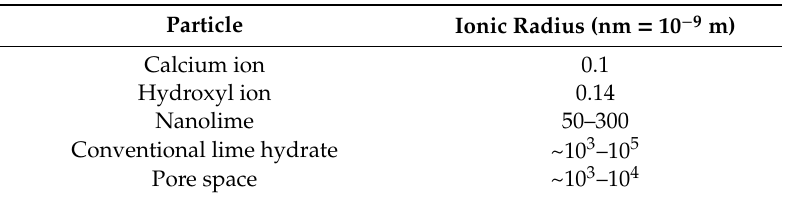
Table 1. Sizes of different particles [9].